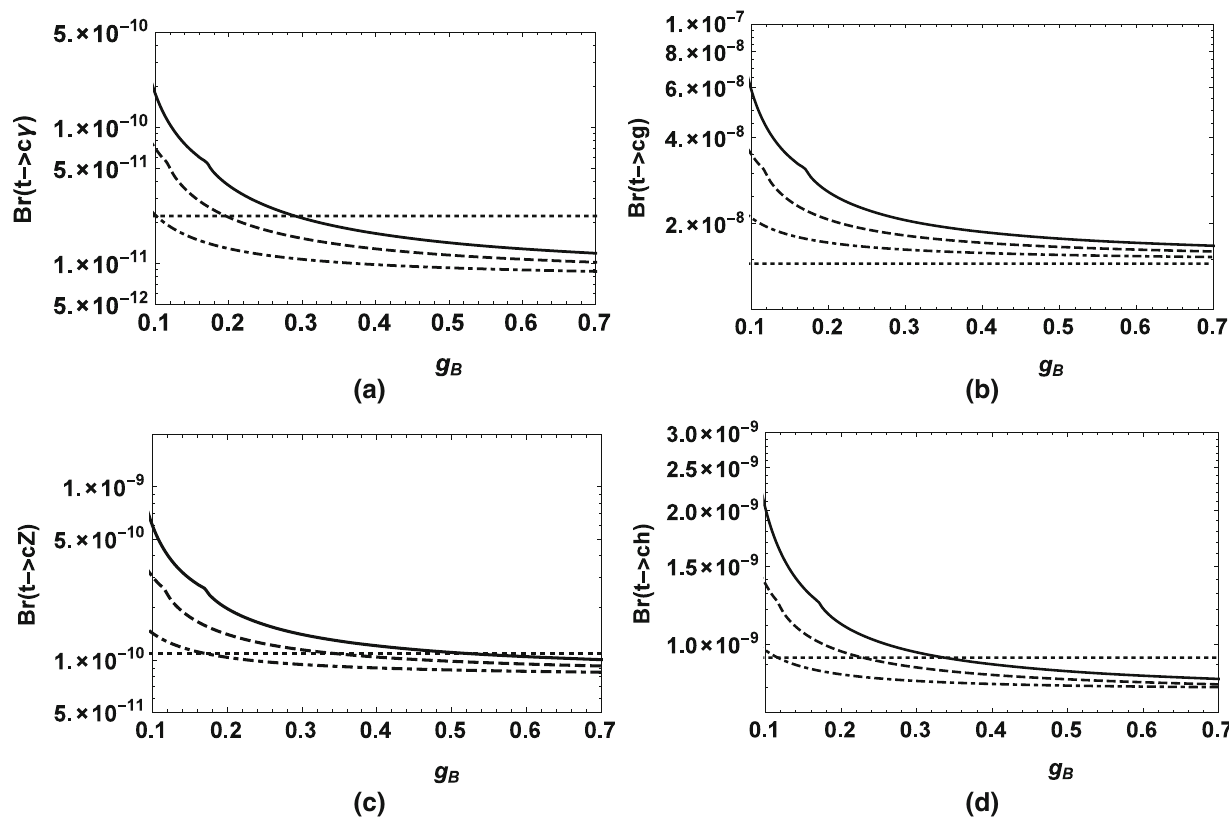
= − 0 . 6 ( solid line ), g = for g B YB YB